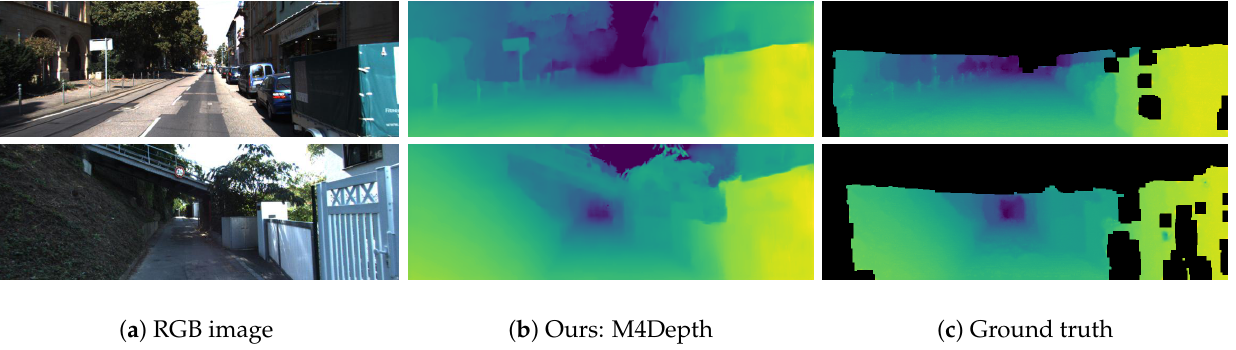
Figure 5. Comparison of depth maps estimated by M4Depth on the KITTI dataset with the corre- sponding interpolated ground